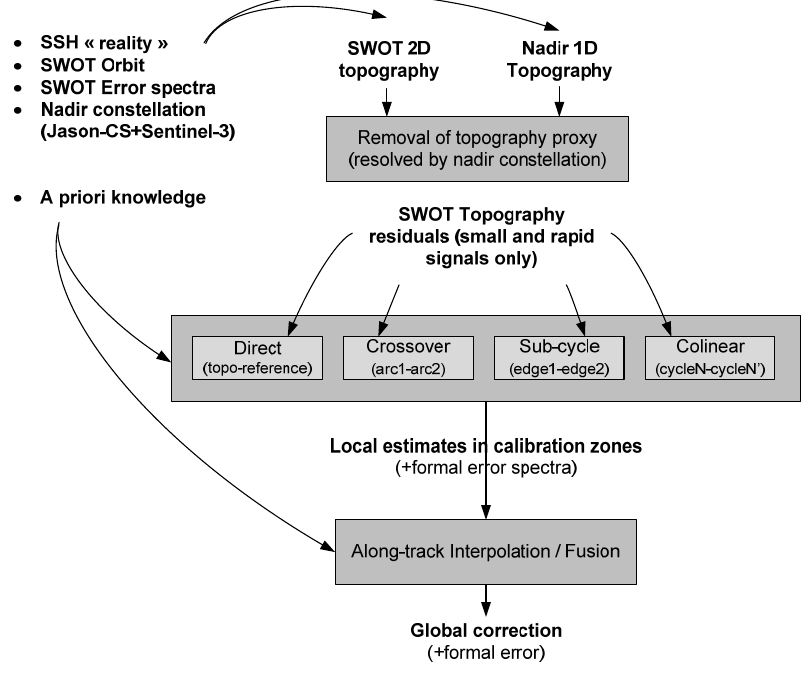
Figure 7. Overview of SWOT’s empirical cross-calibration scheme. Step 1 uses 1D topography profiles from the nadir altimetry constellation (e.g., Jason-CS + Sentinel-3) to generate a large/slow proxy of the SSH field ( i.e. , scales resolved by nadir altimetry) that is removed from SWOT’s 2D image. In step 2, the residual SSH images are processed by multiple roll estimation methods on independent crosscalibration zones. In step 3, all local roll estimates are merged in an interpolation / fusion process to handle gaps and